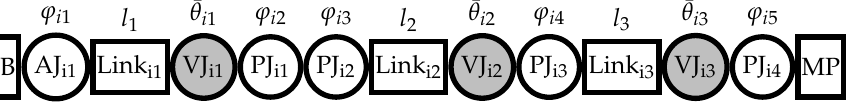
Figure 2. Compliant kinematics of the manipulator where AJ is active joint, PJ is passive joint, VJ is virtual joint, MP is mobile Platform, and B is